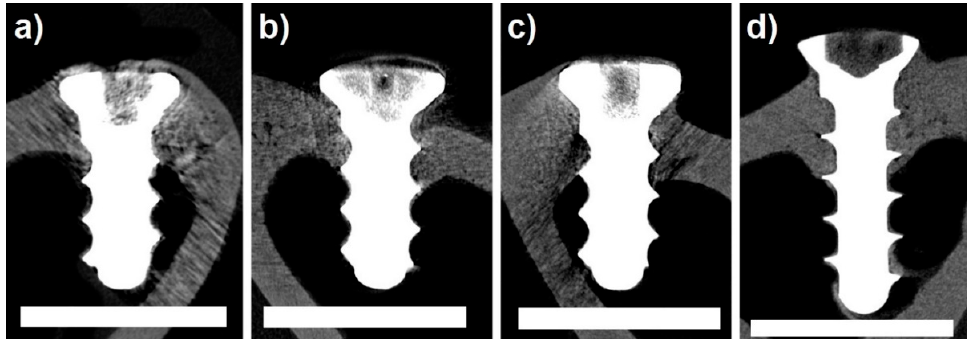
Figure 3. Micro-CT cross-sectional images; ( a ) tested implant, 120 days of healing; ( b ) tested implant, 240 days of healing; ( c ) tested implant, 360 days of healing; ( d ) control specimen (Ti-based screw). All specimens showed bone healing without any signs of adverse reaction. To enhance clarity, image noise was reduced except around the areas of the bone and implant. Scale bar = 4 mm.